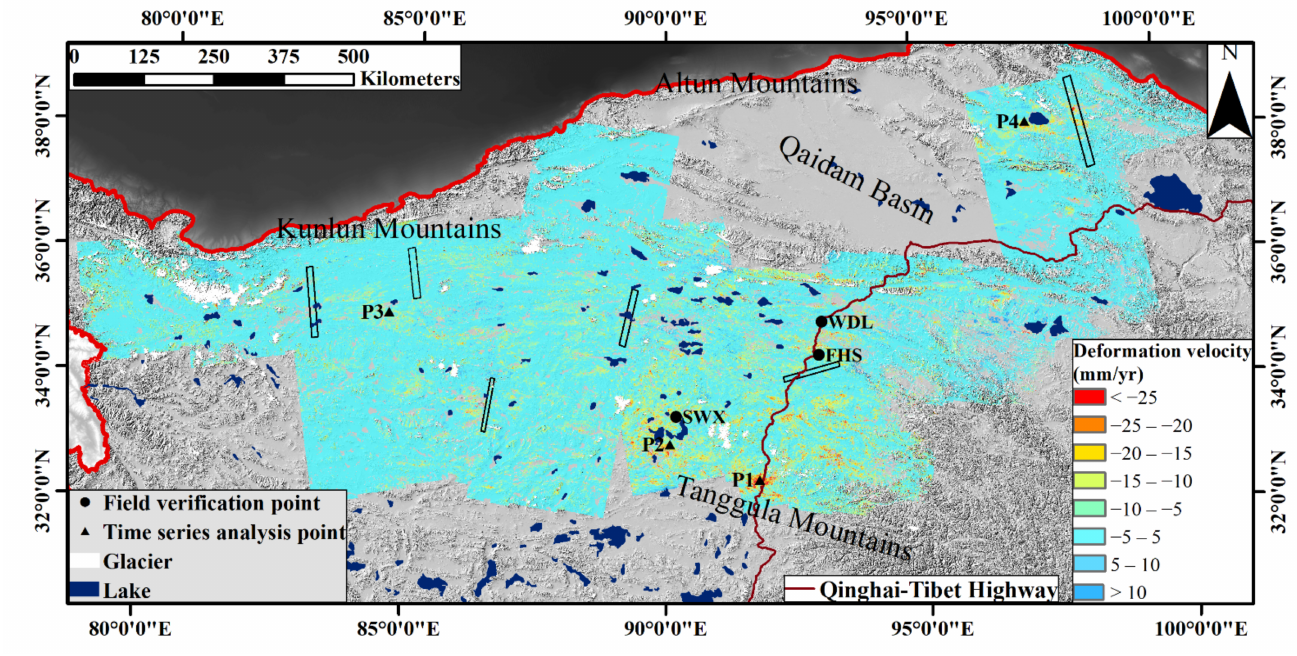
Figure 4. The linear deformation velocity in permafrost area of QTP. The six black boxes in the figure are the overlapping areas for intercomparison of linear deformation velocity in Section 4.2.1, and P1–P4 are the points for analyzing time-series deformation in Section 5.2. The black circle is the point for field